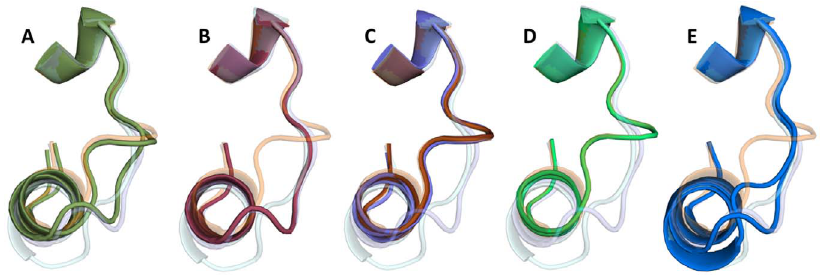
Figure 6. Conformation of the flexible loop of C.Esp1396I in the mutant crystal structures. The three wild type loop conformations observed in 3G5G and 4I6R are shown in the same colours as in Figure 5 and are translucent. (A) T36A loop positions shown in green. (B) Y37A loop position shown in dark red. (C) Loop positions in both R46A structures shown in red (monoclinic space group) and purple (trigonal space group). (D) Loop position of S52A shown in light green. (E) Loop positions in Y37F